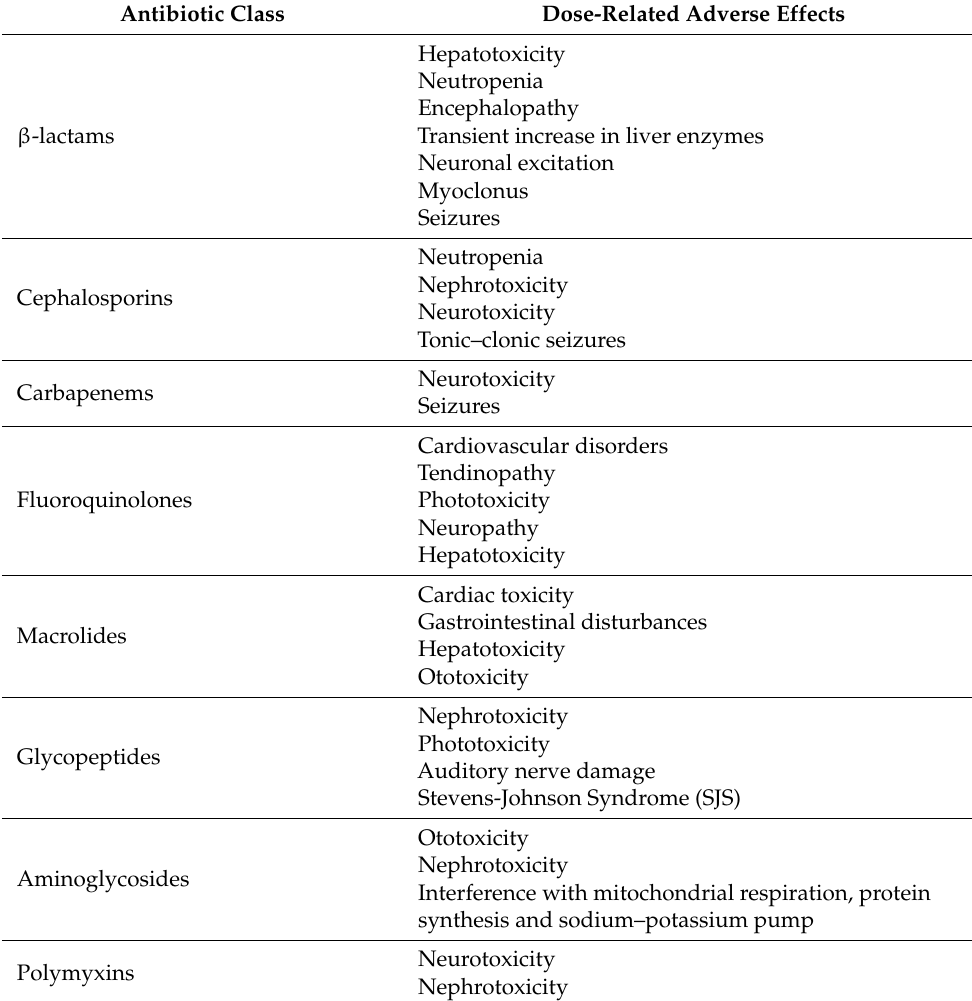
Table 4. Increased dose of antibiotic classes and their dosage-related adverse effects (adapted from ref.